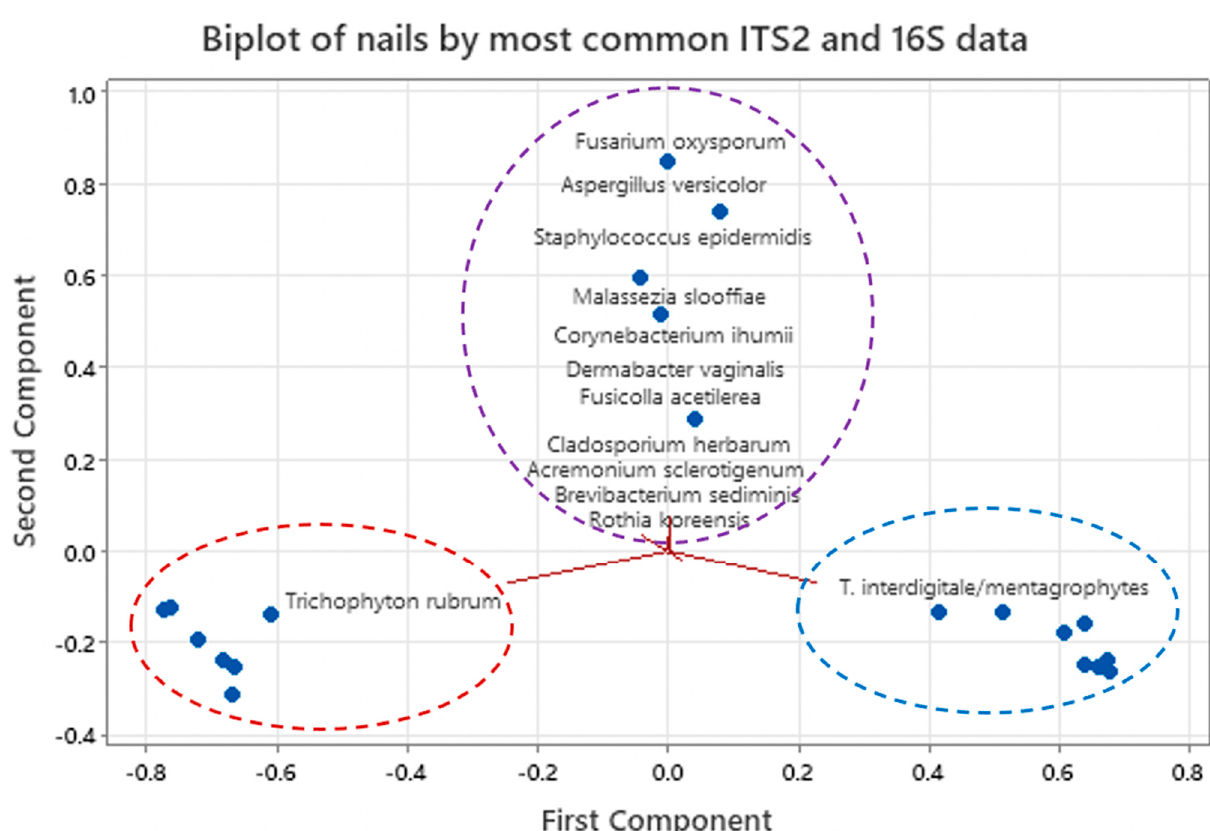
Figure 4. Biplot from Principal Components analysis of combined ITS2 and 16S data.